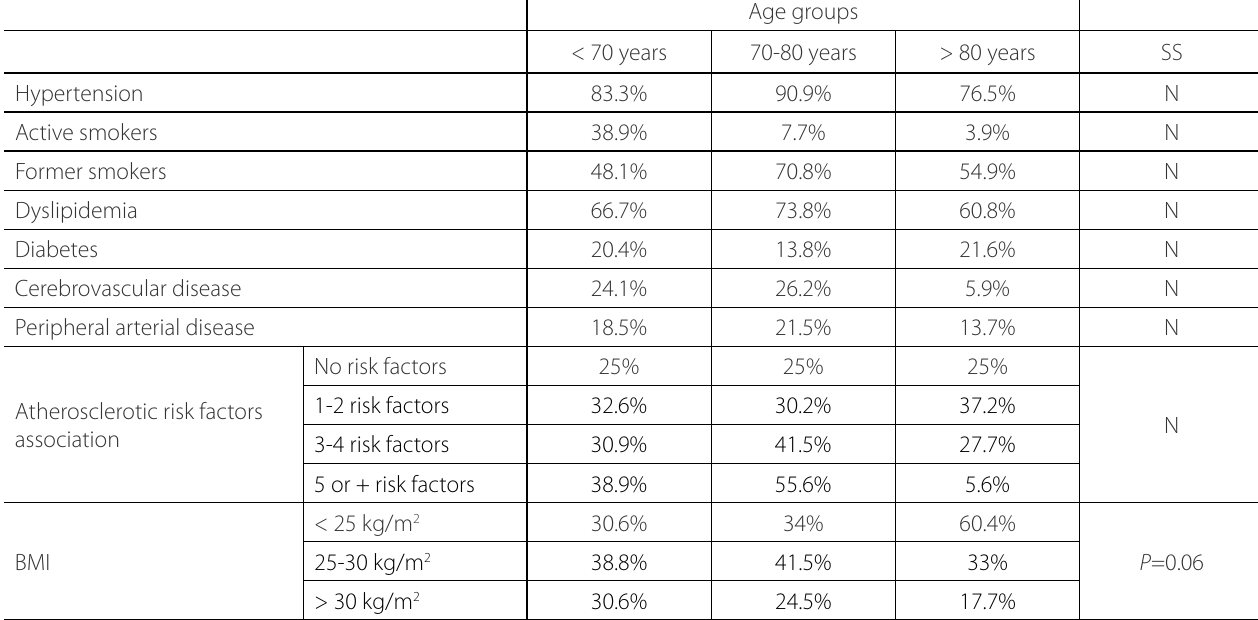
Table 2. Atherosclerotic risk factors, cerebrovascular disease, peripheral arterial disease and body mass index (kg/m 2 ), by age group.